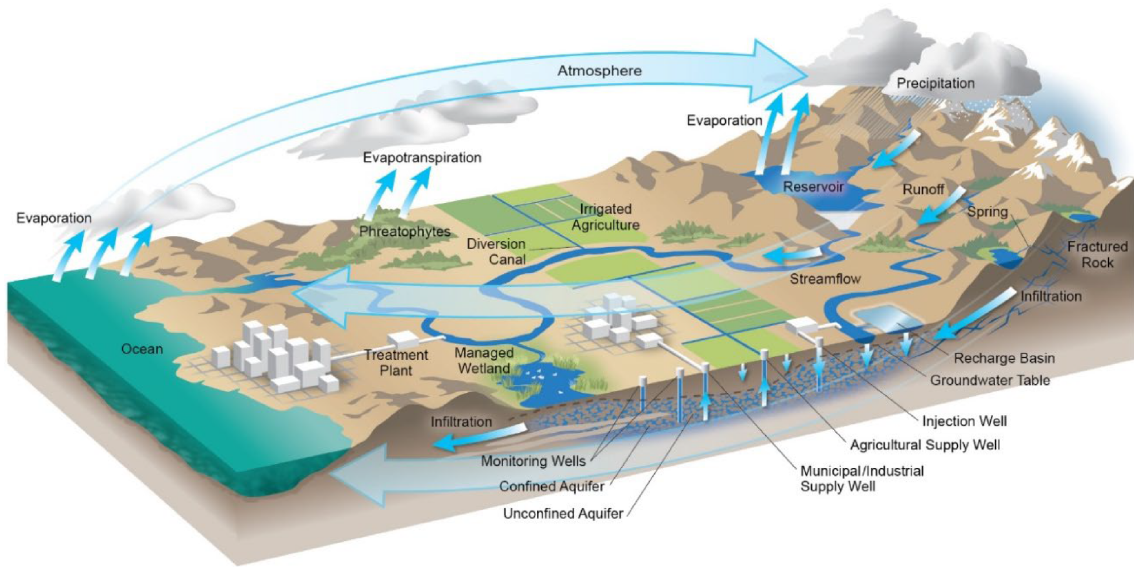
Figure 3. Conceptual model of a hypothetical coastal hydrologic system featuring a major river, cities, agricultural irrigation, an alluvial aquifer system being recharged using various MAR systems, and more. Complexities arise from (i) the number of different processes operat- ing within the basin and their associated parameters, (ii) a need to quantify the diverse array of water exchanges within the hydrologic cycle, (iii) water uses that need to be metered, (iv) potential groundwater contamination from irrigation return flows, and (v) constraints dictated by sustainable groundwater management (with permission, California Department of Water Resources,